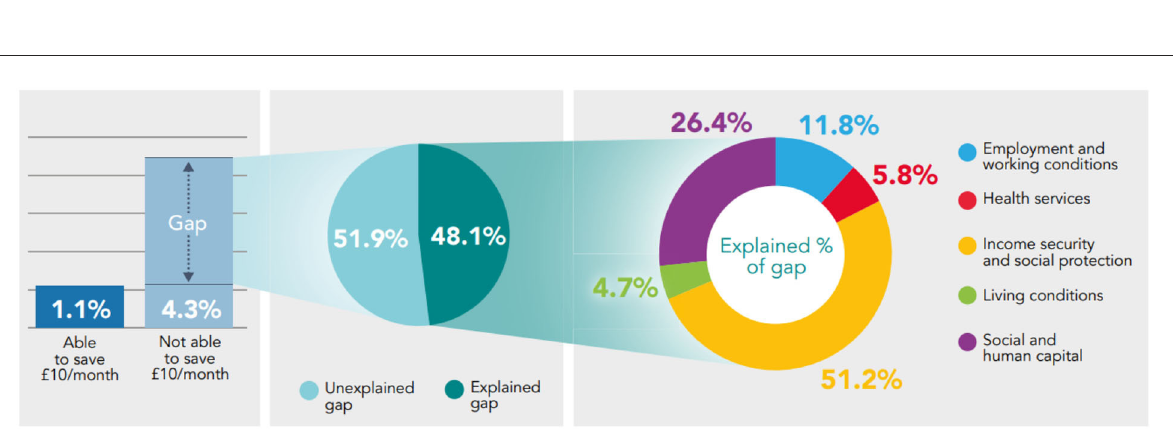
FrontiersinPublicHealth